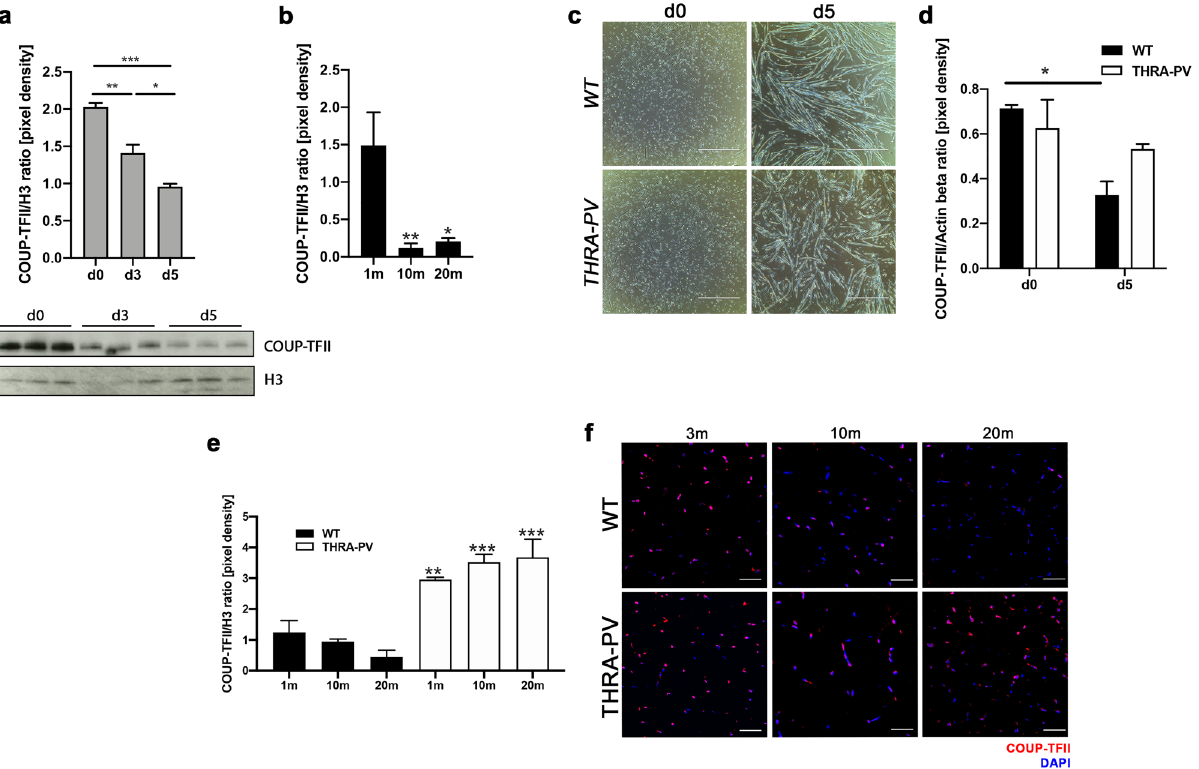
Figure 1. COUP-TFII expression during myogenic differentiation and skeletal muscle aging in THRA-PV mice. ( a ) Western blot of COUP-TFII expression in C2C12 myoblasts before (d0) and at 3 (d3) and 5 (d5) days of differentiation. Upper panel: quantification of the expression normalized to histone H3 (H3). Lower panel: crop of immunoblots of COUP-TFII (47 kDa) and H3 (17 kDa). Full-length gels are presented in Supplementary Figure S1. ( b ) Western blot analysis of COUP-TFII expression in skeletal muscle of WT mice at different ages (1, 10 and 20 months). ( c ) Phase contrast images of WT and THRA-PV myoblasts before (d0) and after 5 days of differentiation (d5). Scale bar = 1000 µm ( d ) Western Blot analysis of COUP-TFII expression in WT and THRA-PV myoblasts from before differentiation (d0) and five days post-differentiation (d5). ( e ) COUP-TFII protein expression in skeletal muscle of THRA-PV and control littermate mice during aging at 1, 10 and 20 months. ( f ) Immunofluorescence for COUP-TFII in WT and THRA-PV skeletal muscle at 3, 10 and 20 months. COUP-TFII in red, DAPI in blue. Scale bar = 25 µm. Data are shown as mean ± SEM, n = 3. One or two-way ANOVA: * p < 0.05, ** p < 0.01, *** p < 0.001, in ( b ) compared to 1 month and ( d ) compared to age- matched control